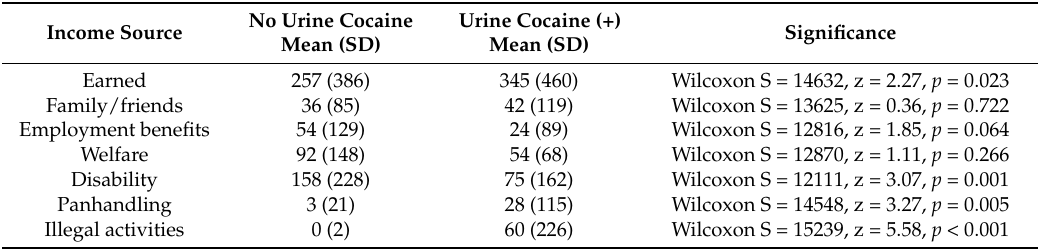
Table 7. Total amounts earned from various 30-day income sources among those with and without 30-day drug expenditures across three interviews.